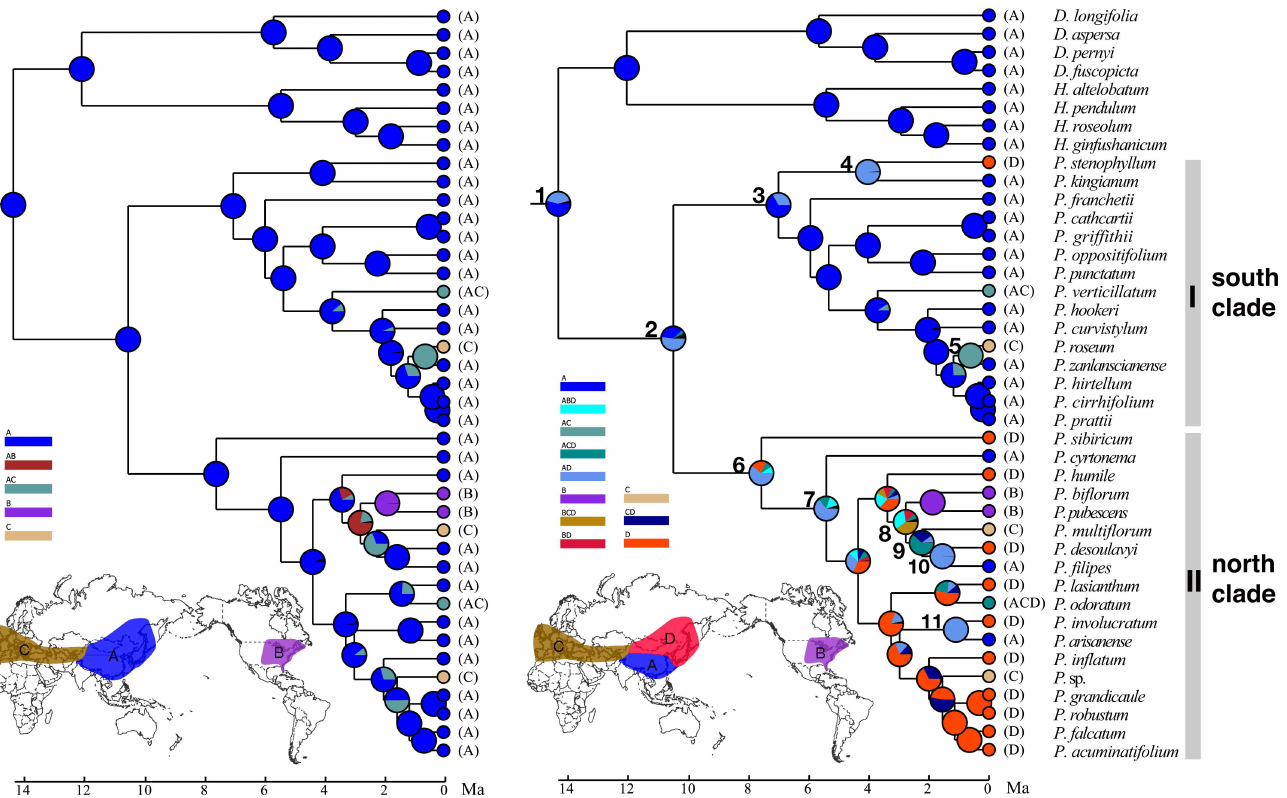
Fig 2. Reconstruction of ancestraldistributions in Polygonatum using Bayes-Lagrange optimizations. Pie charts at nodes represent relative frequenciesof ancestral-area reconstructions. The letter and color-codingof regionsfor each tree is indicatedon the map. Numbers 1–11 indicate nodes of interest (see Table 2 for